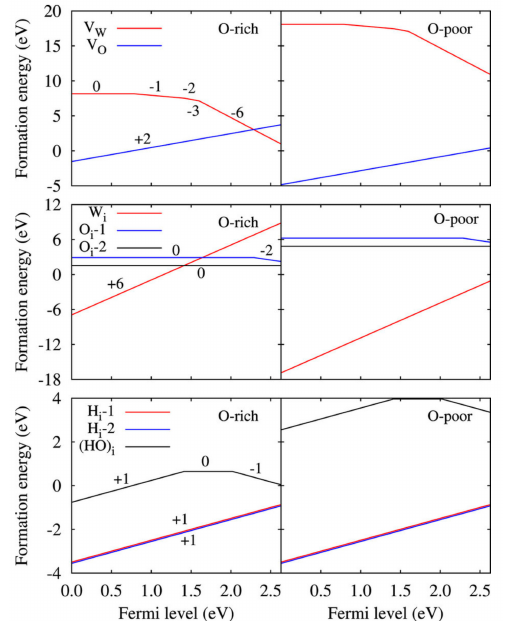
Figure 9. Formation energies of intrinsic and H-related defects in WO 3 with respect to the Fermi level (O-rich and O-poor limits) for a range of charge states